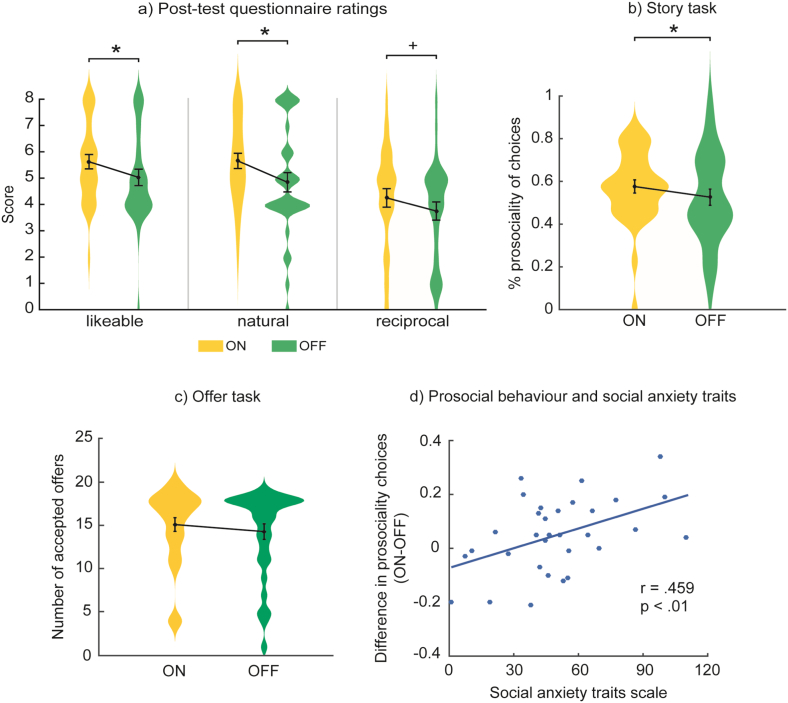
a) Post-test questionnaire ratings about the confederates: mean (filled circle), SE (error bars), and frequency of values (width of distribution). b) Percentage of prosociality of choices in Story task. c) Number of accepted offers in the Offer task. d) Correlation between prosocial behaviour and social anxiety traits in Story task. Asterisks signify difference at p < .05 (*), p < .01 (**) and p < .001 (***).